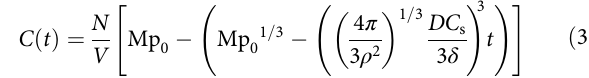
(min)0 0.4 Retention time Fig. 4 Drug fi lms and powders chemical characterization. UPLC of: ( a ) caffeine, ( b ) tamoxifen, ( c ) BAY 11-7082, ( d ) paracetamol